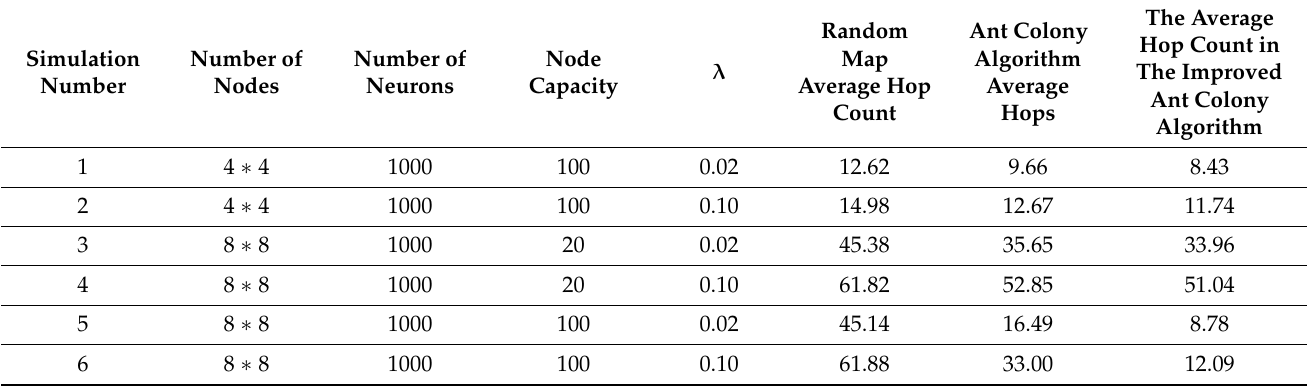
Table 1. Simulation results of the ant colony